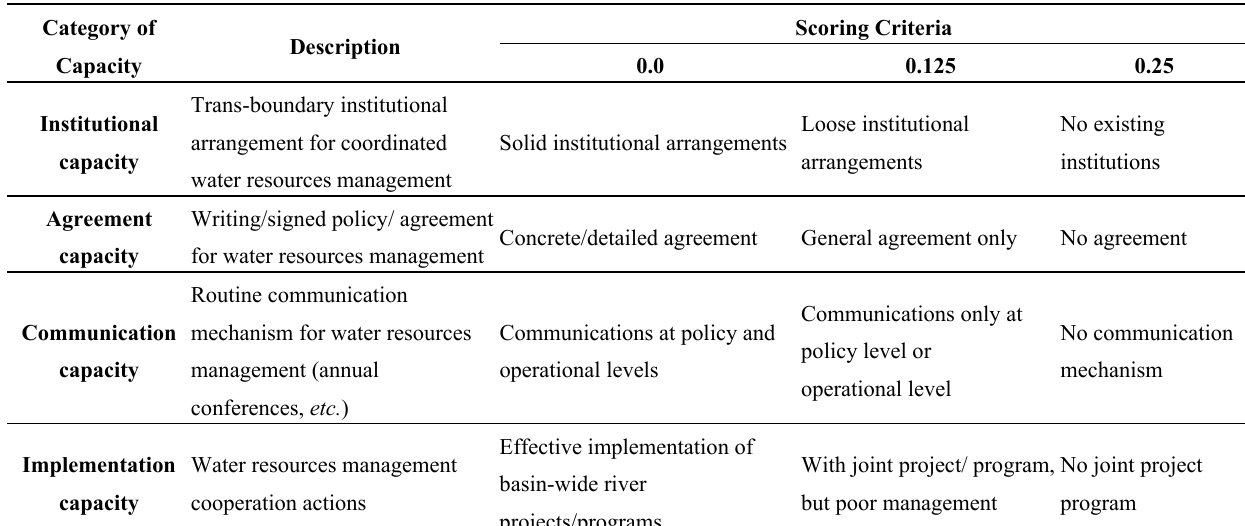
Table 2. Conflict management capacity parameter assessment matrix (Source: